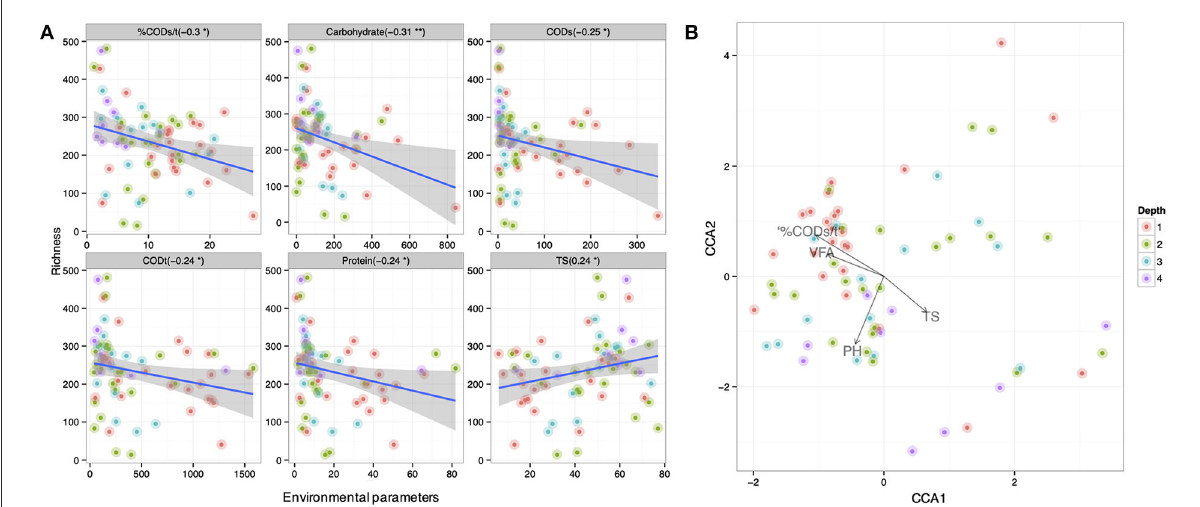
FIGURE5 (A) Correlation between richness of samples at depth 1, 2, 3, and 4 (70 samples with 14,803 OTUs; and colored by depth) and the environmental parameters. Here only the significant parameters are shown. (B) Canonical correspondence analysis of community data against significant environmental parameters (based on PERMANOVA) for samples at depths 1, 2, 3, and 4. Depth 1 = 20cm, Depth 2 = 40cm, Depth 3 = 60cm, and Depth 4 =